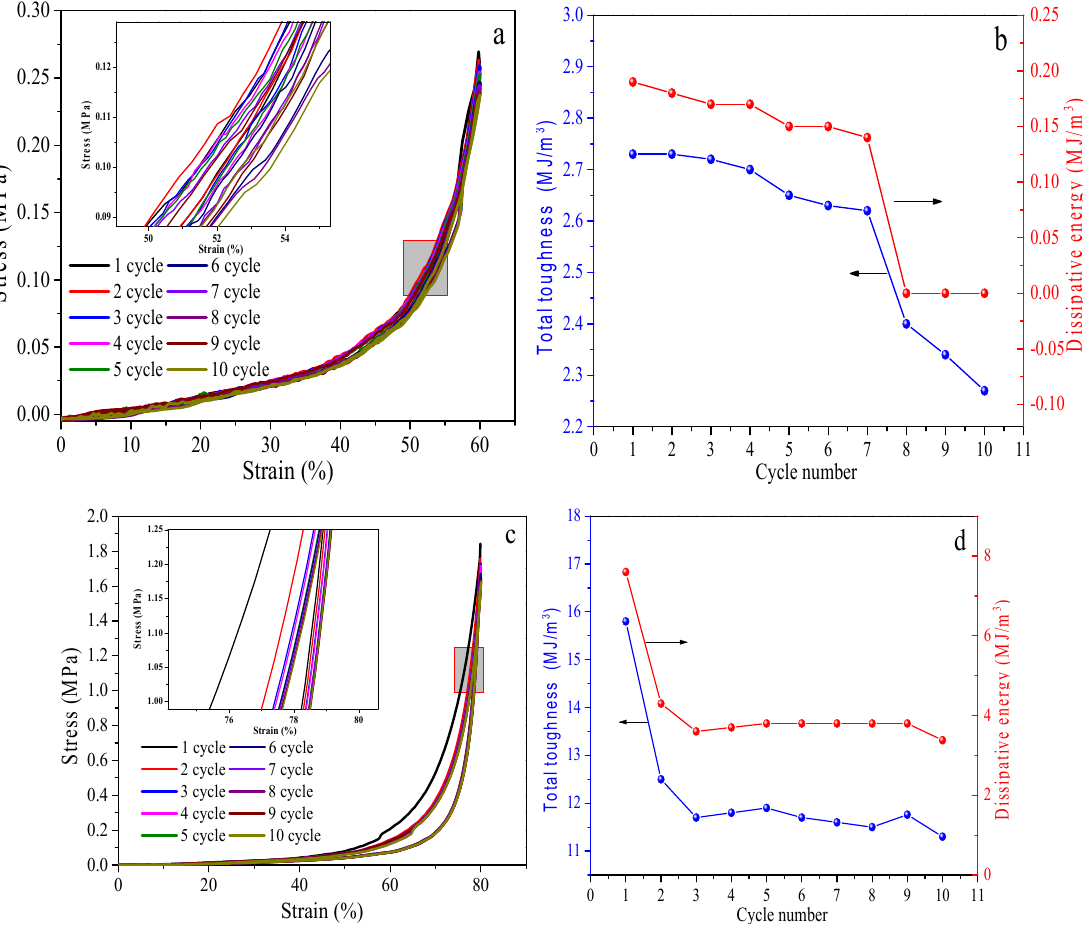
Figure 7. Ten cycles compression stress–strain curve and dissipated energy of p–DN hydrogel (( a ): 60% strain; ( b ): dissipated energy at 60% strain; ( c ): 80% strain; ( d ): dissipated energy at 80% strain).